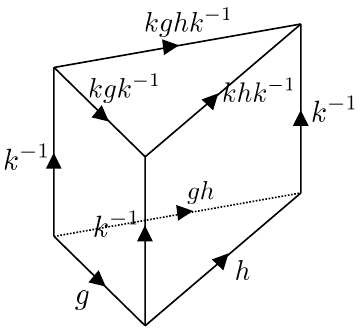
Figure 39: The prism interpolating between two gauge equivalent